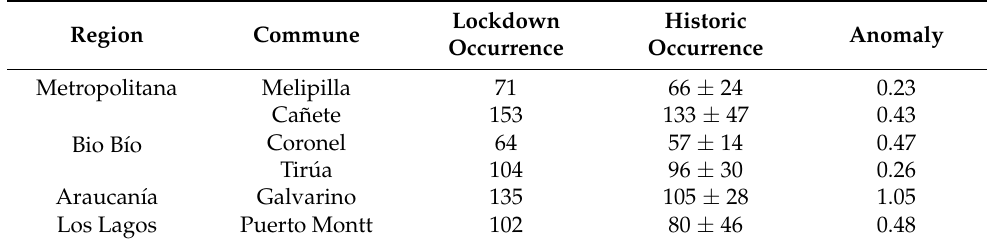
Table 3. Communes with positive anomalies in the occurrence of forest fires. Period 15 May 2020– 15 May 2021.